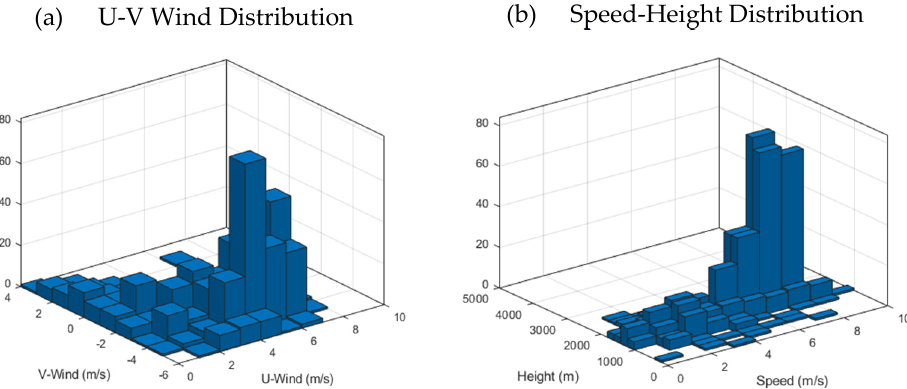
Figure 16. ( a ) Joint distribution of U-V winds and ( b ) speed-height from the MODIS-GOES stereo run corroborate the CMIS winds.